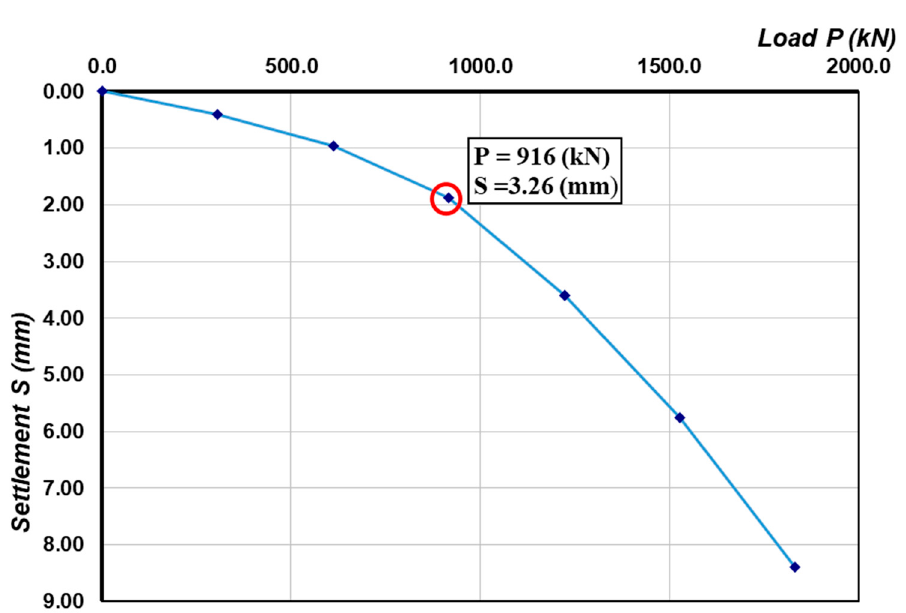
Figure A2. Load–settlement relationship for pile number P_140.